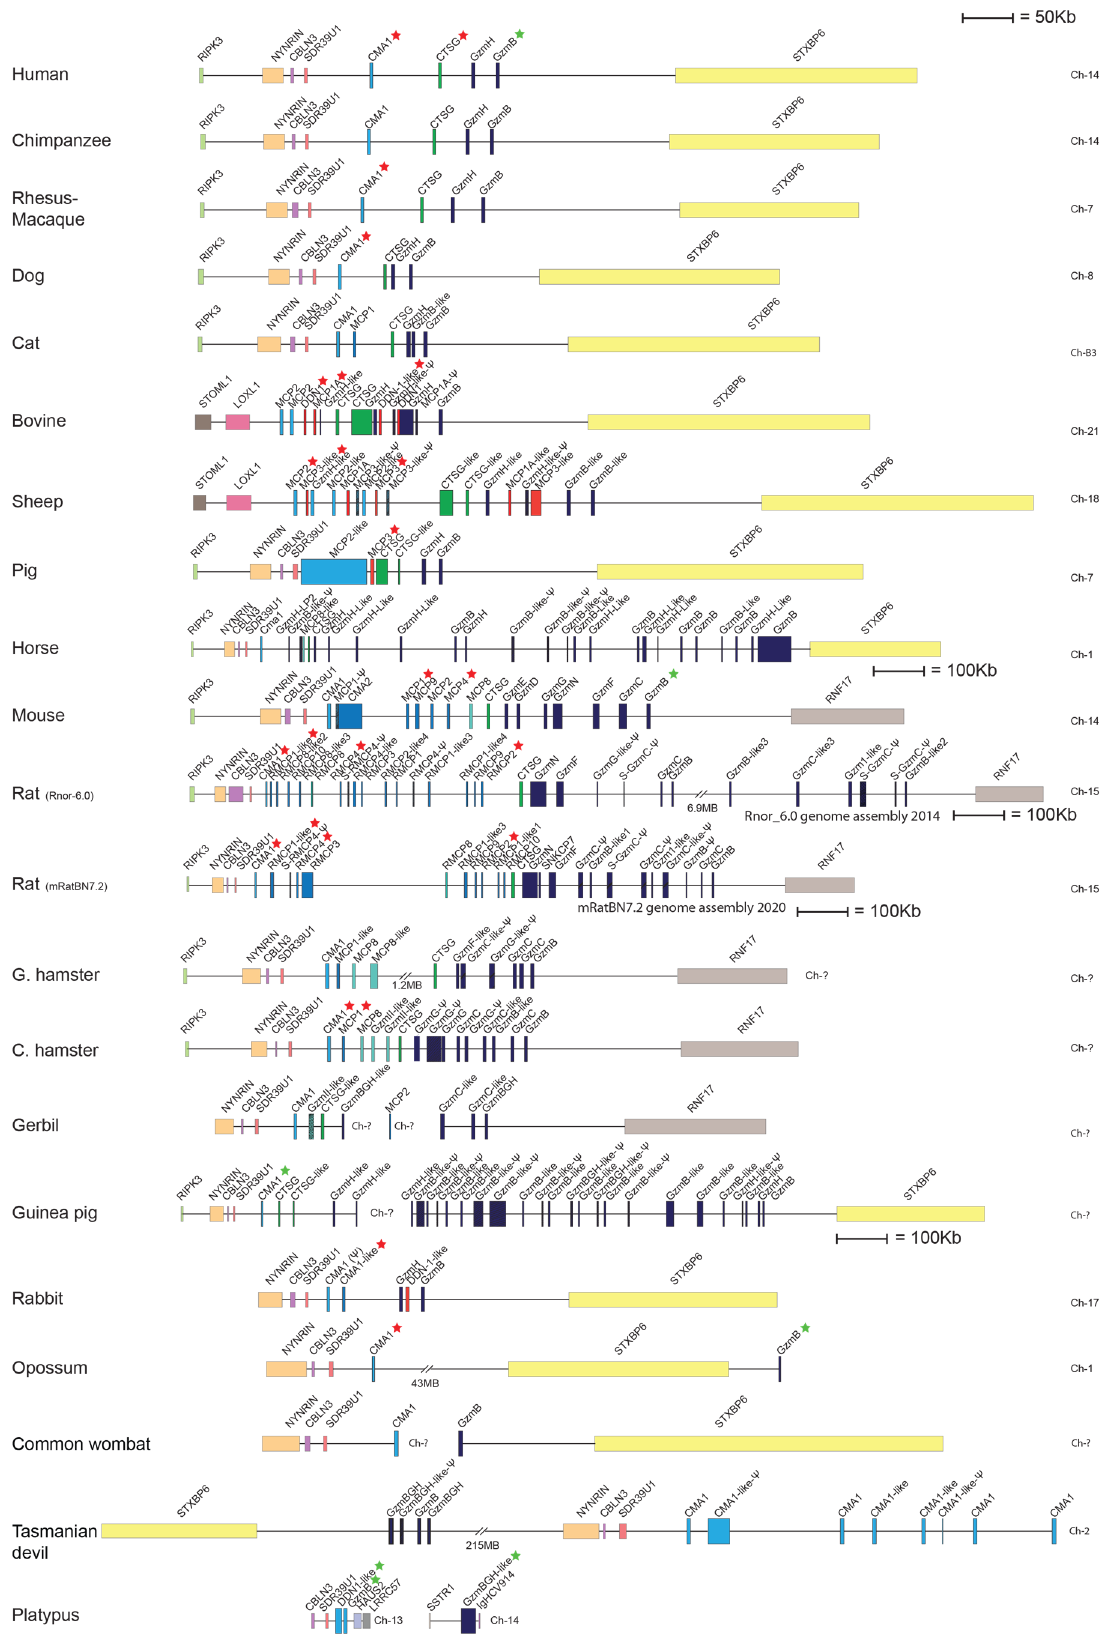
Figure 1. The chymase locus of a panel of mammalian species. An in scale figure of a panel of mammalian species ranging from humans to marsupials and monotremes. The genes are color coded. Granzymes are shown in dark blue, α -chymases in light blue and β -chymases as blue with a darker tint. mMCP-8-related genes are in cyan, duodenases in red and